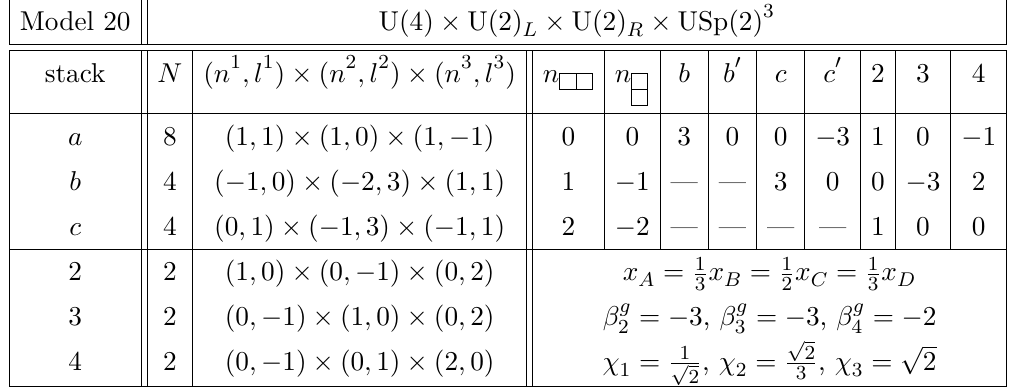
Table 27 . D6-brane configurations and intersection numbers of Model 20, and its MSSM gauge